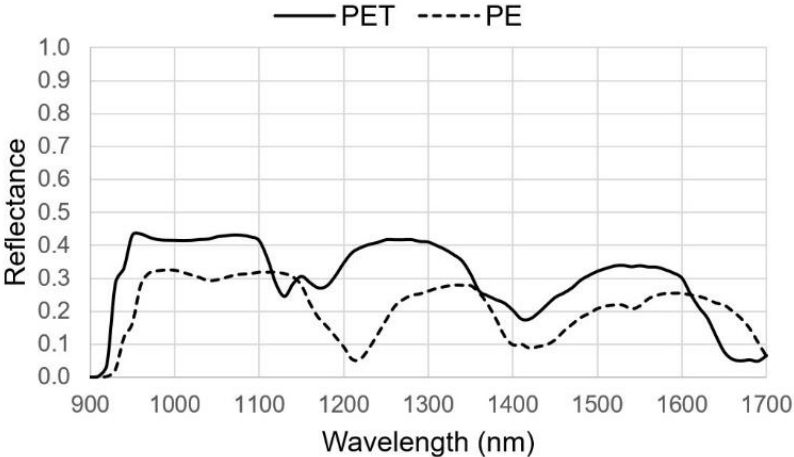
Figure 1. Spectral signatures of plastics typologies measured in laboratory-controlled conditions (Balsi et al., [7]).